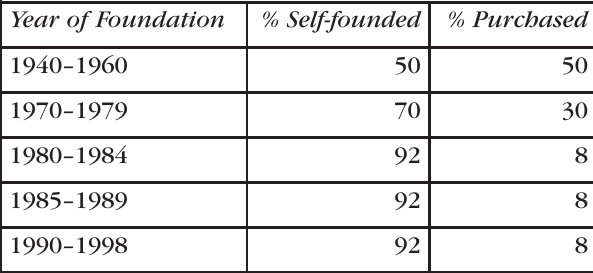
Table 4. Correlation between Year and Type of Foundation